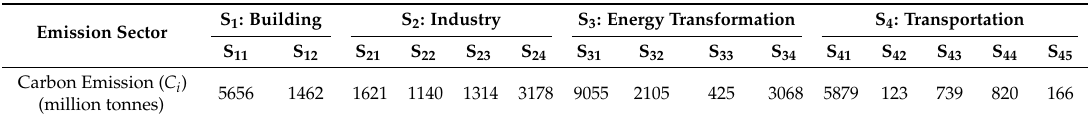
Table 4. Carbon emissions released by various sectors.